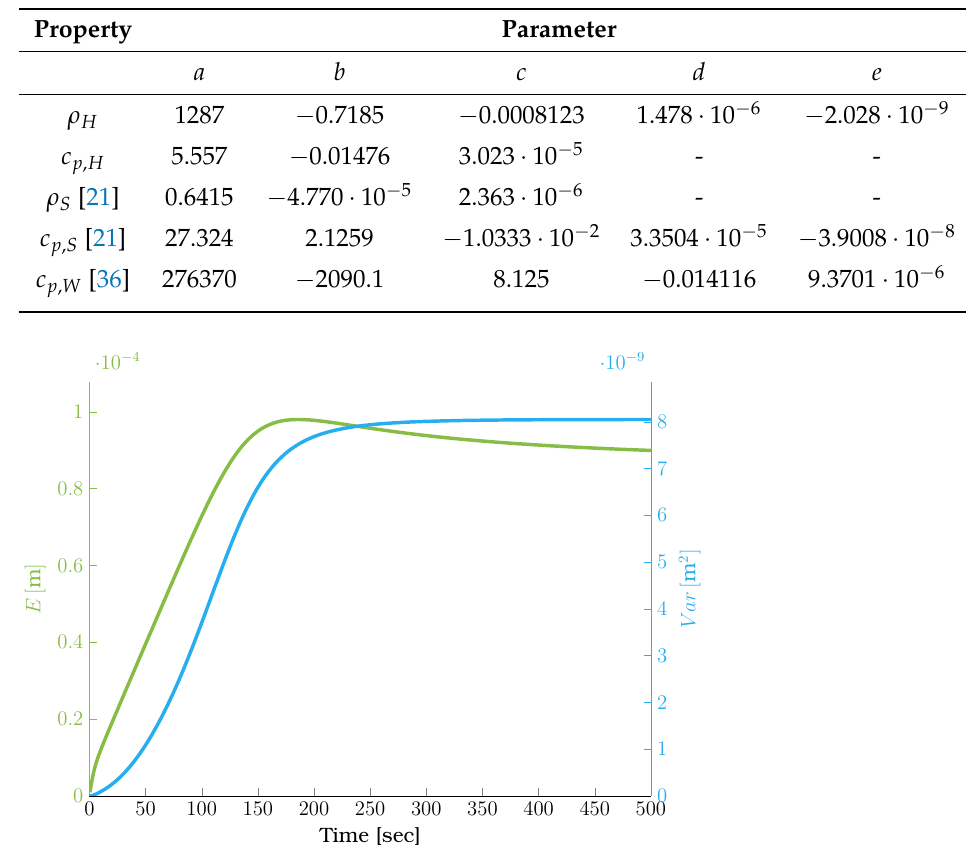
Figure A1. The evolution of the expected value and the variance in the case of the isotherm batch